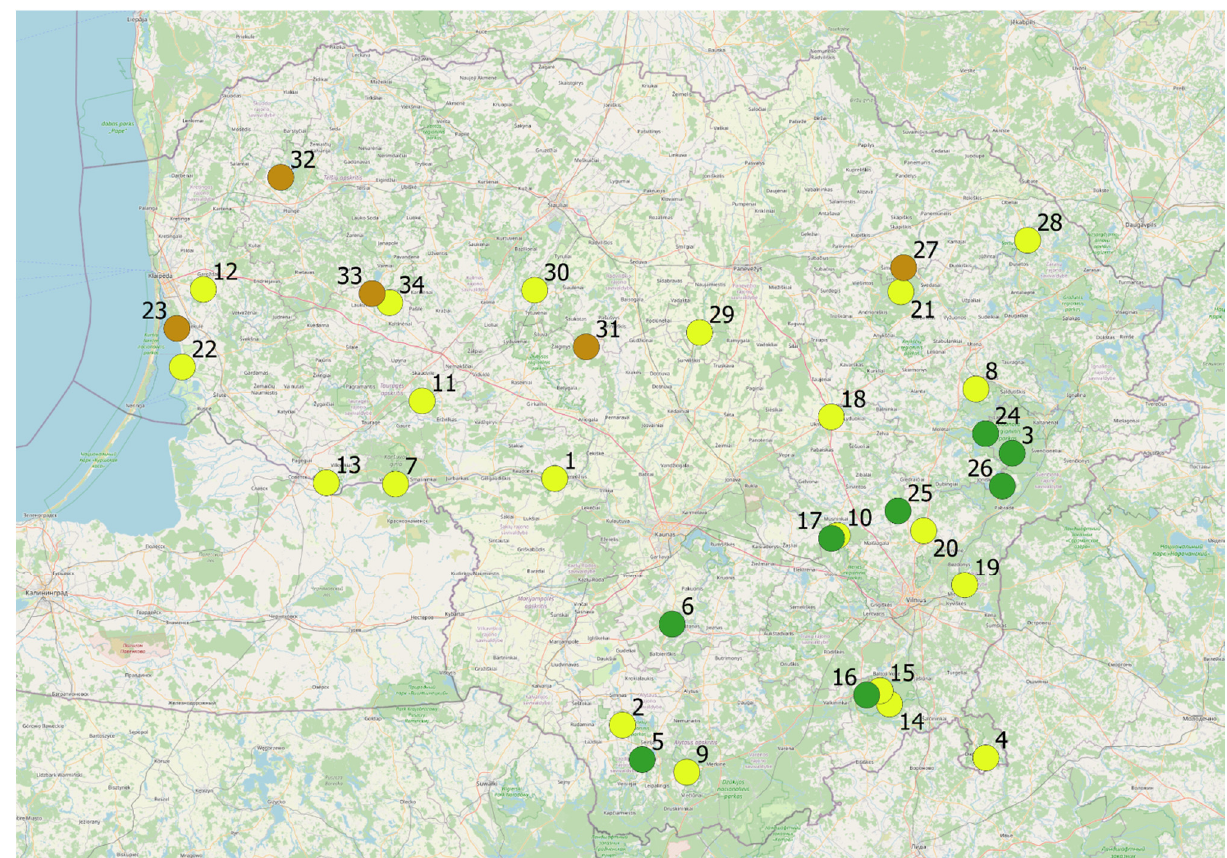
Figure 2. Distribution of 34 medicinal plant genetic reserve sites in Lithuania. Prevailing habitat types: yellow circles —meadows; green circles —forests; brown circles —mires.